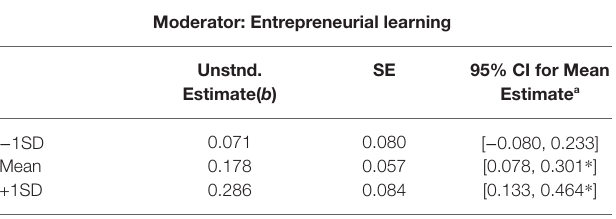
TABLE 5 | Conditional indirect effects of entrepreneurship education on entrepreneurial intention through opportunity recognition for different values of entrepreneurial